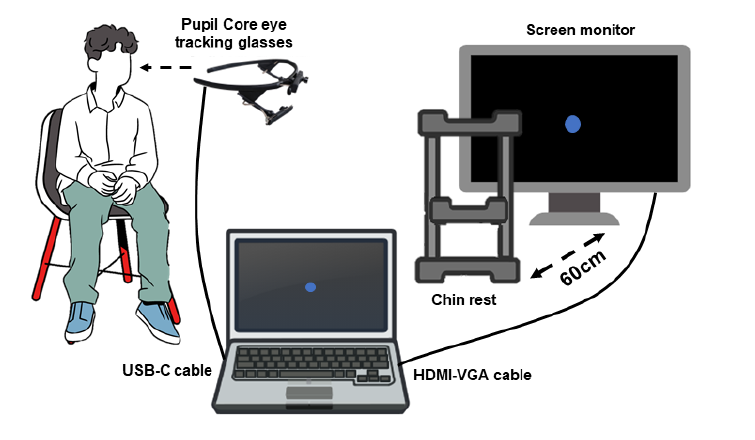
Figure 2. Scheme of the eye movements tests’